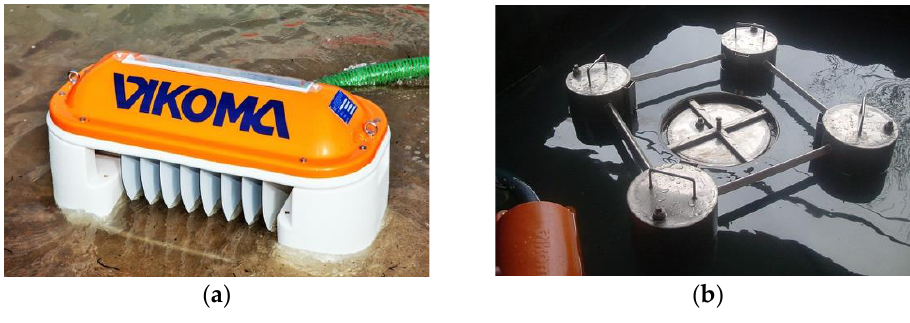
Figure 3 . Disc skimmer ( a ) and weir skimmer ( b ) [11]. Figure 3. Disc skimmer ( a ) and weir skimmer ( b )